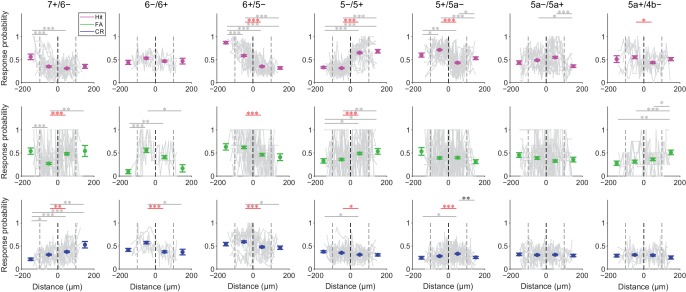
Broad correspondence between functional boundaries and AldC expression boundaries at the microzone level.Probability of response during the early response window (0 to 0.5 s from cue onset) in single ROIs (gray dots) for each trial type (hit, magenta; FA, green; CR, blue) plotted as a function of relative distance from AldC expression boundaries (gray lines; single lines represent single imaging sessions). Colored dots and error bars represent the means and s.e.m. of single ROI response probability within 100 µm bins from AldC expression boundaries, pooled across sessions and animals (lateral 100–200 μm bin, lateral 0–100 μm bin, medial 0–100 μm bin, and medial 100–200 μm bin; 7+/6−, n = 5 mice, 12 imaging sessions, 18, 147, 147, and 11 ROIs; 6−/6+, n = 3 mice, four imaging sessions, 8, 48, 40, and 6 ROIs; 6+/5−, n = 8 mice, 13 imaging sessions, 19, 140, 143, and 23 ROIs; 5−/5+, n = 9 mice, 15 imaging sessions, 34, 199, 161, and 33 ROIs; 5+/5a−, n = 8 mice, 16 imaging sessions, 21, 168, 209, and 37 ROIs; 5a−/5a+, n = 3 mice, 13 imaging sessions, 35, 159, 159, and 26 ROIs; 5a+/4b−, n = 2 mice, six imaging sessions, 13, 69, 74, and 23 ROIs). Red horizontal lines and asterisks represent significant difference between adjacent 100 μm bins across AldC expression boundaries. Gray horizontal lines and asterisks represent significant difference between the other pairs of 100 μm bins. Black vertical dashed lines represent AldC expression boundaries. Gray vertical dashed lines represent other boundaries between 100 μm bins. One-way ANOVA on ranks with repeated measures followed by post-hoc Tukey’s test: *p<0.05, **p<0.01, ***p<0.001.10.7554/eLife.47021.010Figure 2—figure supplement 1—source data 1.Datasets used to create Figure 2—figure supplement 1.